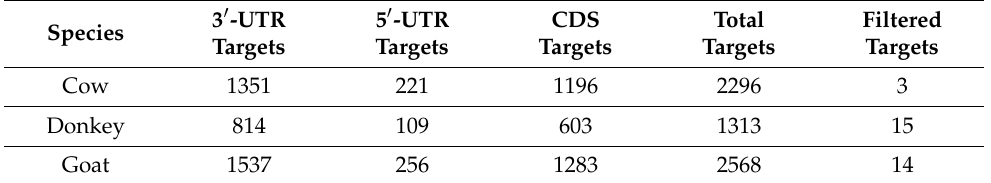
Table 2. Number of total and selected targets retrieved for each